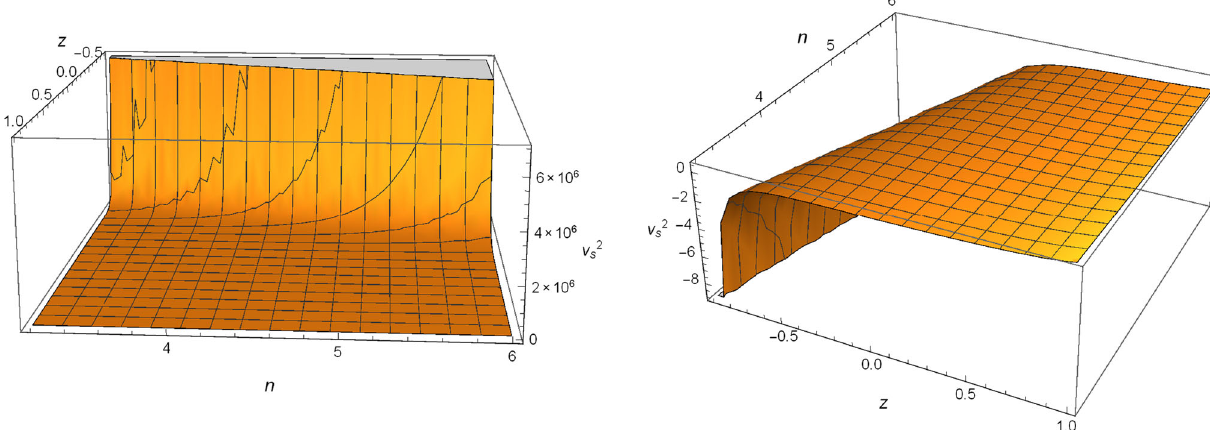
Fig. 2 Plots of power-law v 2 s for u = 2 (left) and − 2 (right)